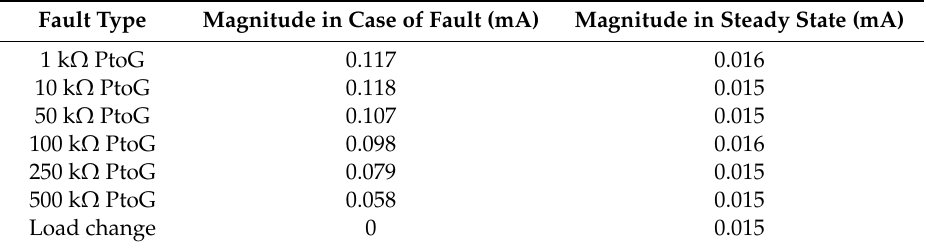
Table 1. The performance analysis results.